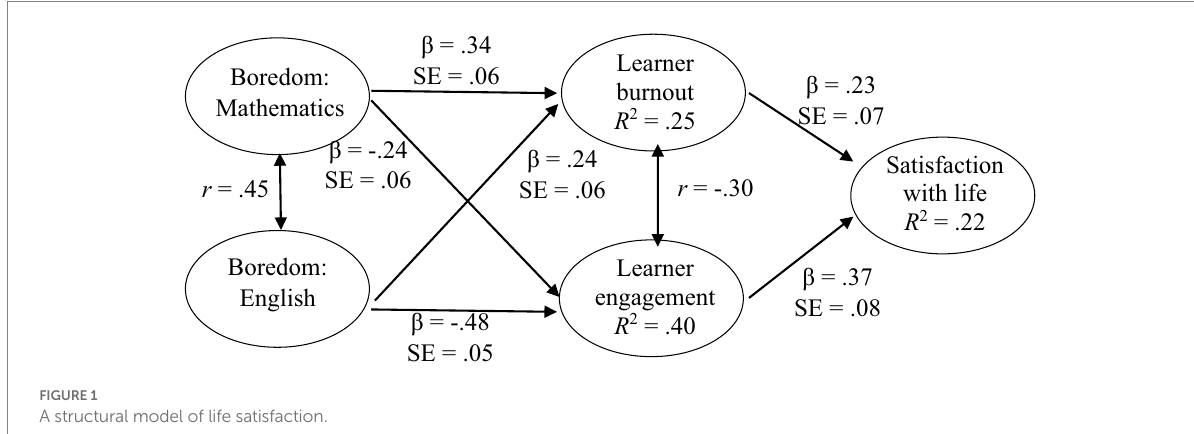
FIGURE 1 A structural model of life